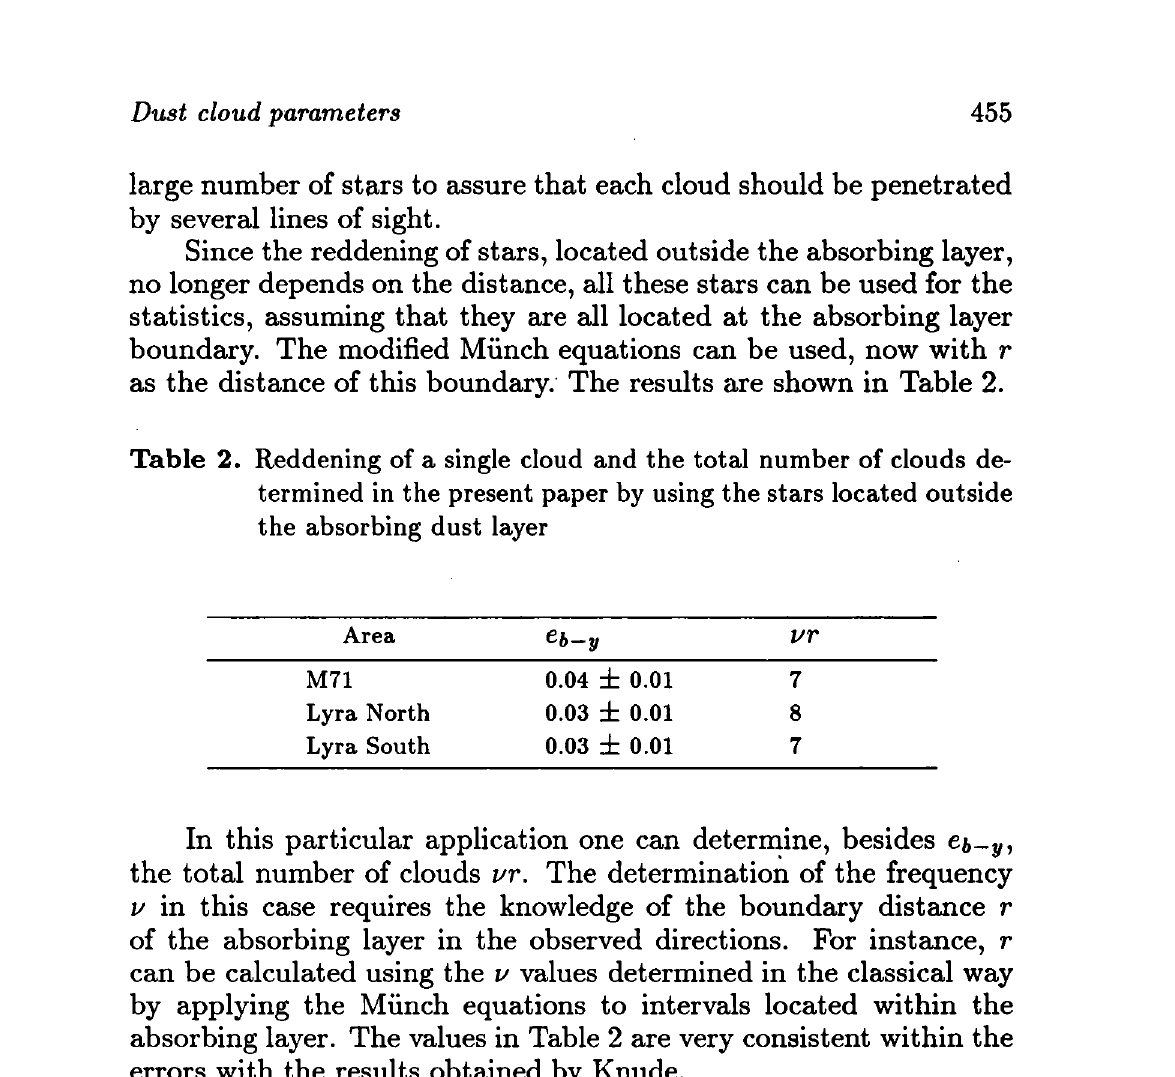
Table 2. Reddening of a single cloud and the total number of clouds de- termined in the present paper by using the stars located outside the absorbing dust